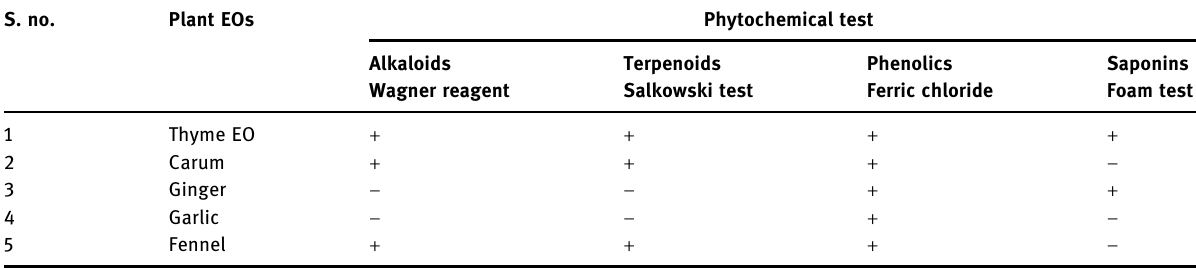
Table 5: Detailed phytochemical analysis of plant EOs S. no.